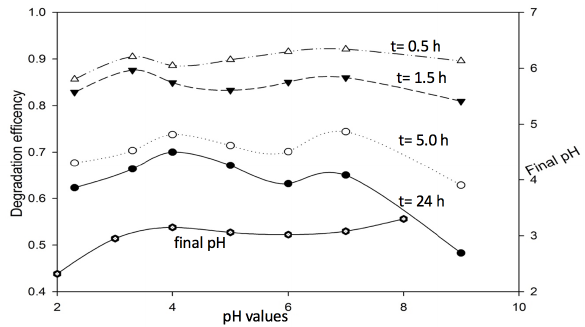
Figure1 : The effect of pH on the degradation of 50 mg/L methylene blue using 1.0 mM PMS and at different reaction